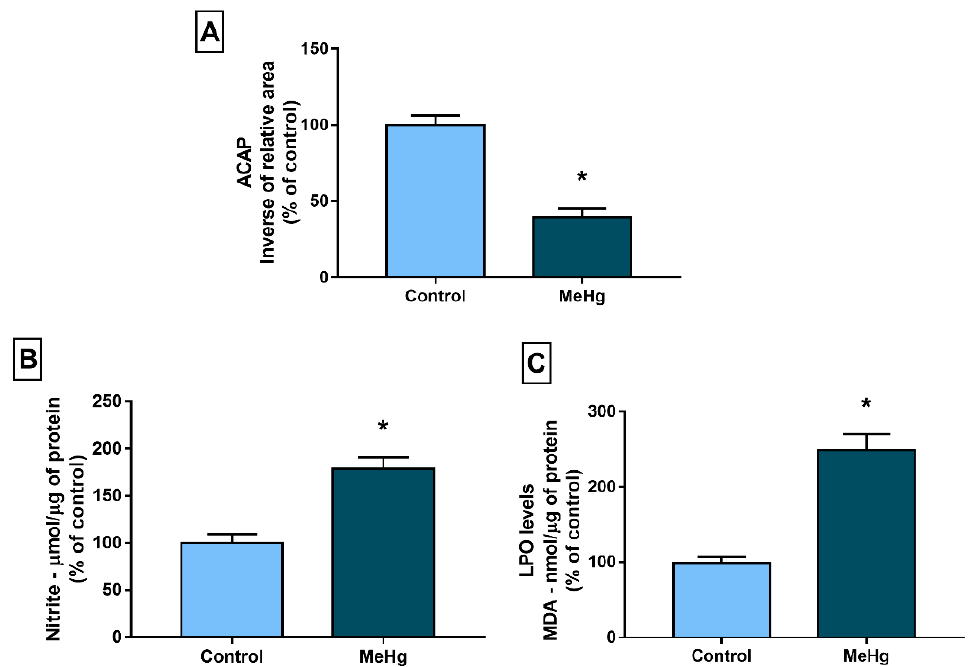
Figure 2. Effects of prolonged exposure to MeHg (40 µ g/kg/day), for 60 days, on the oxidative biochemistry of the cerebellums of Wistar rats. ( A ) Antioxidant Capacity Against Peroxyl Radicals (ACAP). ( B ) Nitrite levels. ( C ) Lipid peroxidation (LPO) levels measured by malondialdehyde (MDA) levels. Results are expressed as means ± standard errors of the mean (SEMs) and converted to percentages of the control group. n = 10 per group. * p < 0.05. Student’s t -test.